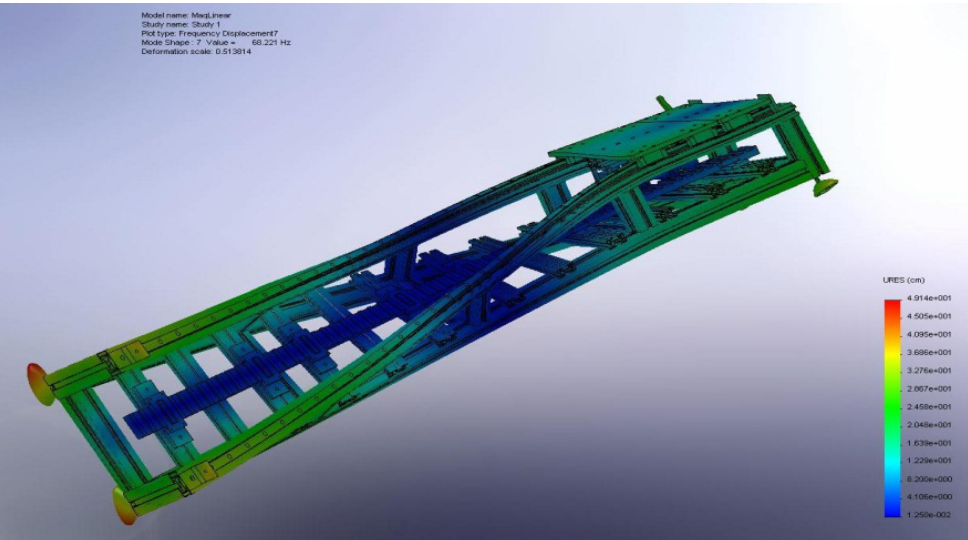
Figure 2. View of the mode shape 7 (74.8 Hz) resultant from the LSRA finite elements simulation